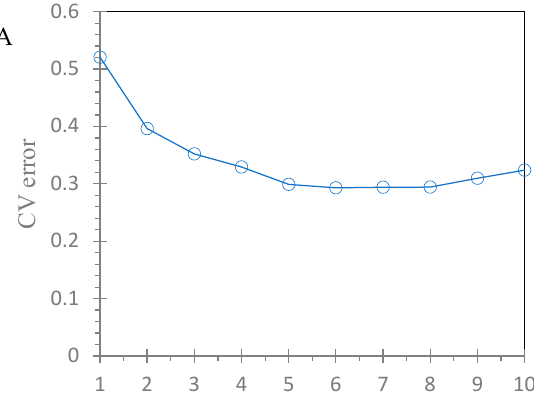
Figure 5. Phylogenetic relationships among ten populations of N. cadamba derived from the haploid nrDNA ITS markers. The phylogenetic tree was drawn using the ML method with 1000 bootstrap resamples.